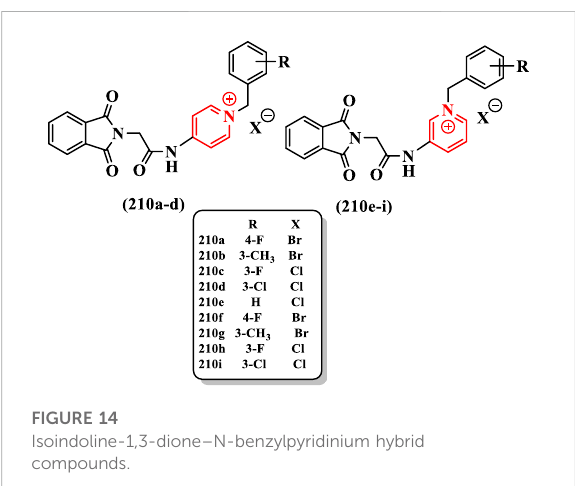
FIGURE 13 Moieties of compounds oxoquinazoline and pyridinium.